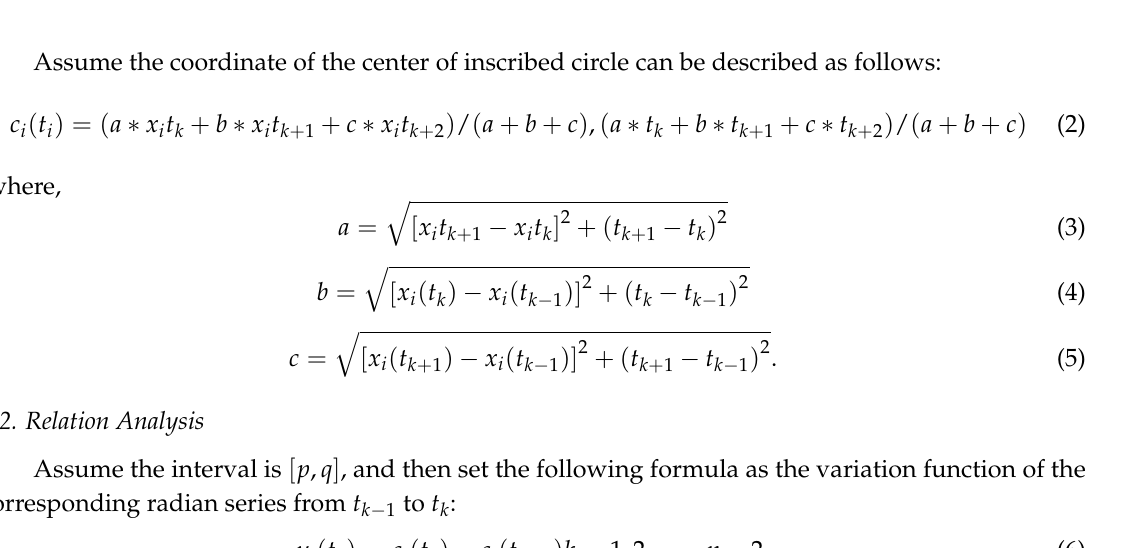
Figure 2. Description of the inscribed core of piecewise linear.